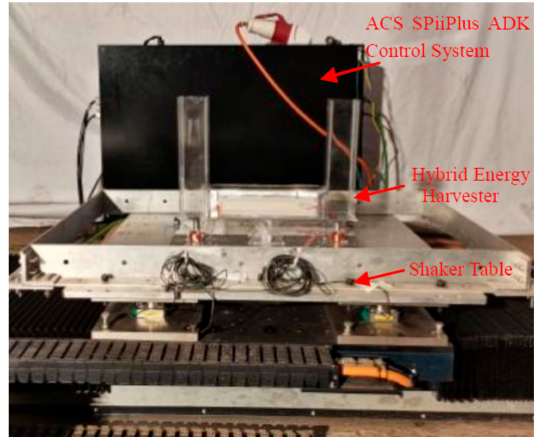
Figure 3. Experimental setup for the hybrid energy harvester. The hybrid energy acquisition device was tested using the aforementioned equip- ment. At each liquid level, the shaking table was designed to apply an external excitation load with the same natural frequency as the device, and the output voltage of the piezoe- lectric and electromagnetic parts under the open circuit and different load resistances were tested, respectively, to evaluate the energy acquisition of the device (Figures 4–6 and Table 1).